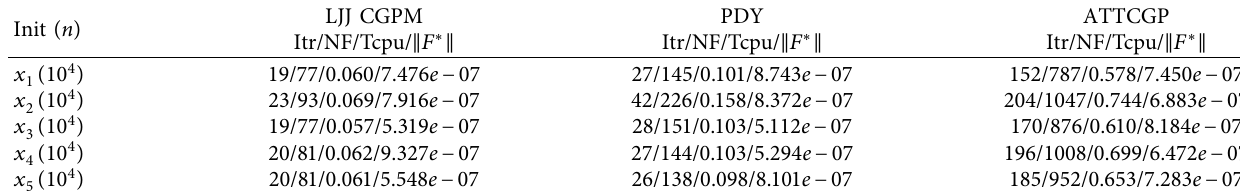
Table 5: Numerical results on Problem